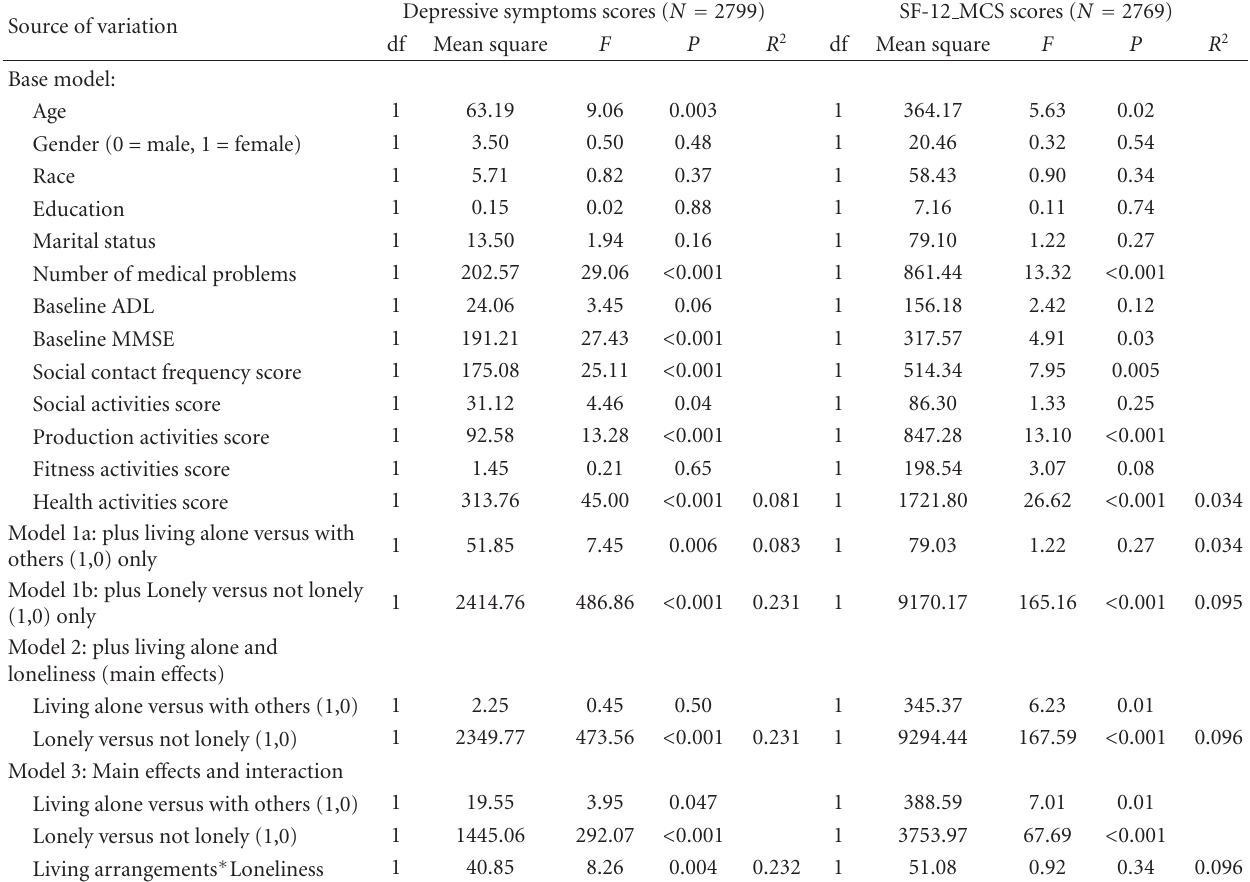
Table 2: Cross-sectional analysis: associations of living arrangement and loneliness with baseline GDS and SF-12 MCS